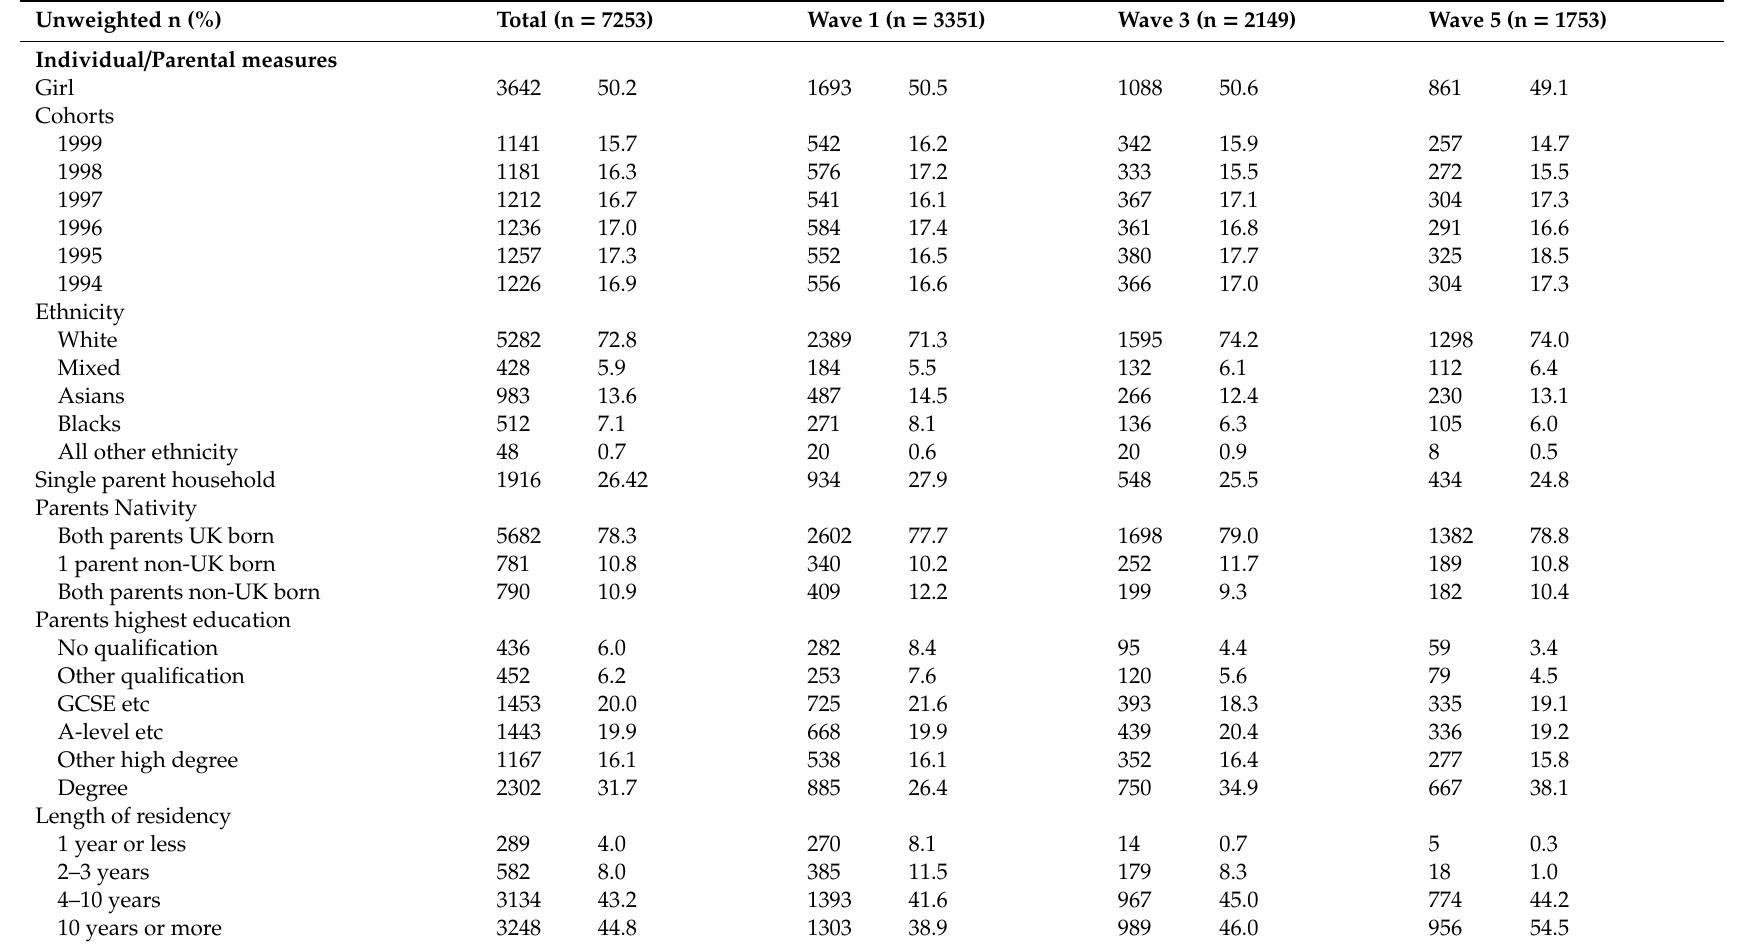
Table 3. Youth, parental and neighbourhood characteristics for the total sample and the sample at each